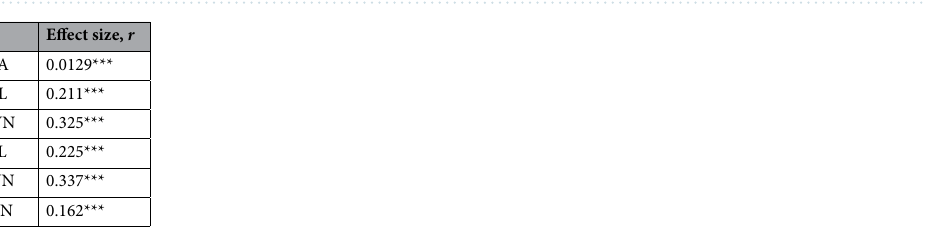
Table 1. Results of the Bonferroni-corrected Mann–Whitney U test to compare each pair of carriers in terms of d . *** p < 0.001 .